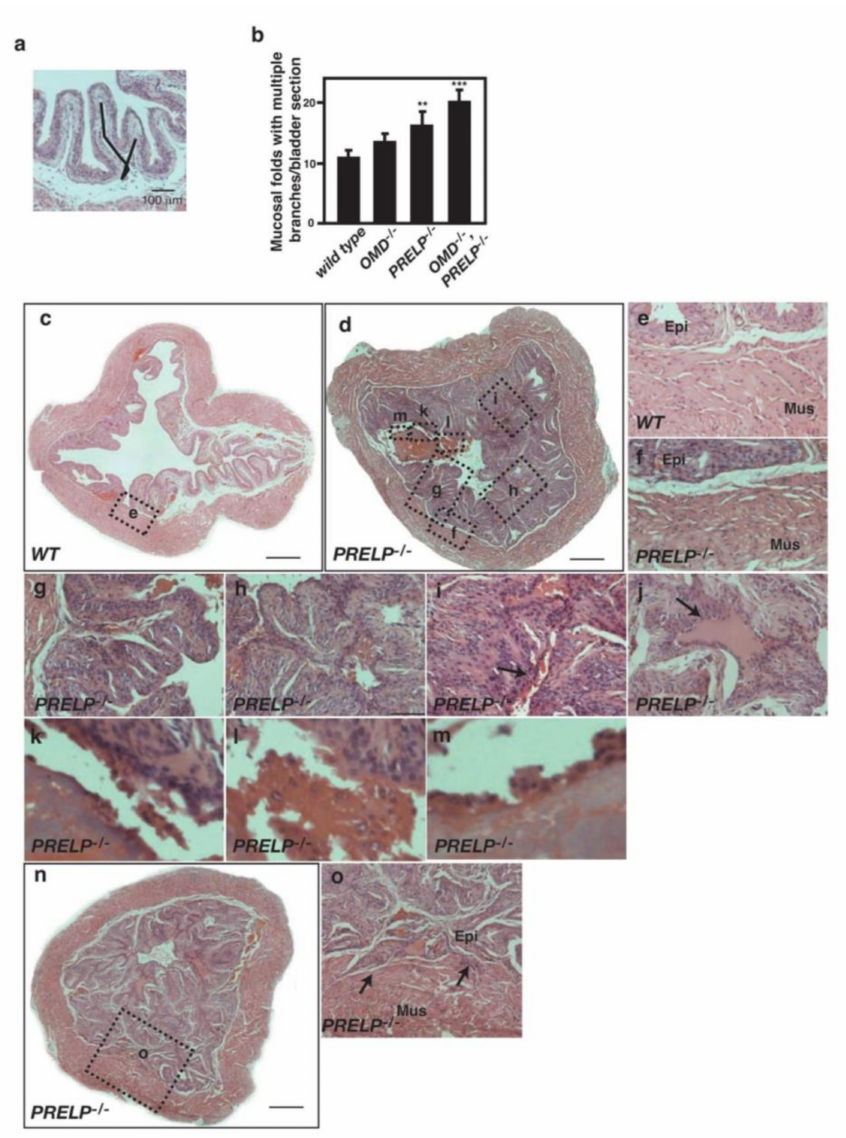
Figure 10. PRELP knockout mice spontaneously initiate early stages of bladder cancer. ( a ) H&E-stained section showing a branched mucosal fold. ( b ) Number of mucosal folds with multiple branches. In each bladder, we have examined two sections in the medial region of bladder. ( c ) H&E-stained section of a WT mouse bladder at 3 months of age. ( d ) Bladder papillary cancer in PRELP − / − at 3 months. Scale bar represents 500 µ m ( c,d ). The bladder lumen is almost completely filled by mucosal folds with multiple branches and fused mucosal folds. Clots formation is observed. Enlarged regions in the following panels are indicated by the dotted boxes. ( e ) WT bladder muscularis (Mus) and epithelial tissue (Epi). ( f ) PRELP − / − bladder muscularis. ( g ) Mucosal fold with multiple branches. ( h ) Partially fused mucosal folds with multiple branches. ( i ) Fused mucosal folds. The arrow points secretion of materials to lumen. ( j ) Fused mucosal folds. Deposited material is enriched in fused folds (arrow). ( k ) Separation of epithelial cells with sticky material. ( l ) Aggregation of separated cells with clot materials. ( m ) The clot is covered by a layer of cells. ( n ) T1 stage bladder cancer in PRELP − / − at 3 months. ( o ) Epithelial papillary cancer integration into muscularis (arrows). ** and *** indicate p < 0.005, and p < 0.001,